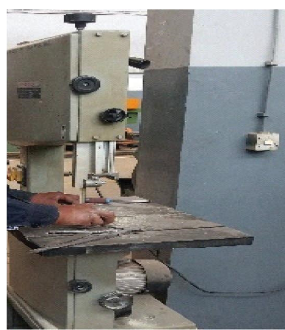
Figure 6: Test specimen preparation using band saw in AAiT.